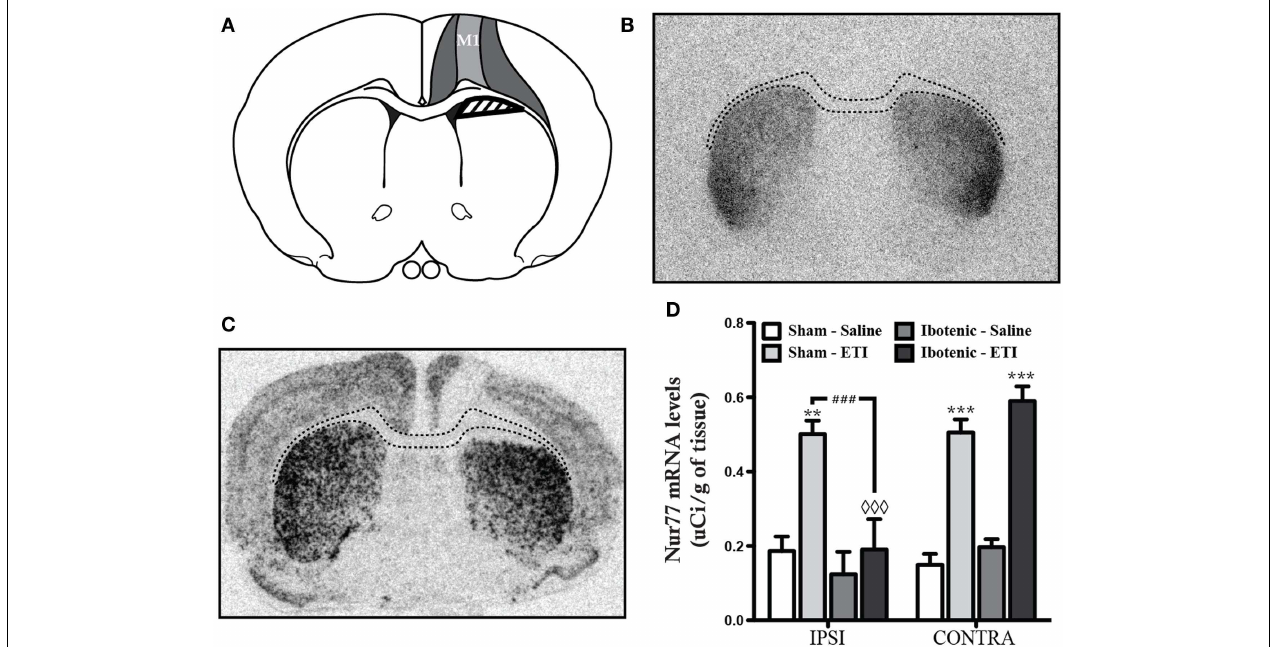
position of the corpus callosum identified on an adjacent section after Nissl staining (not shown). ( C ) Representative autoradiogram showing in situ hybridization of the Nur77 mRNA after eticlopride (ETI) administration. ( D ) Quantification of striatal Nur77 mRNA levels in the ipsilateral (IPSI) and contralateral (CONTRA) sides of the lesion in animals treated with saline or eticlopride (ETI) and bearing a sham or an ibotenic acid-induced lesion. Data are expressed in µ Ci/g of tissue. Histogram bars represent means ± SEM ( N = 5, ** p < 0.01 and *** p < 0.001 vs. same side control (Sham-Saline); ### p < 0.001 vs. IPSI side of Ibotenic-ETI group and ♦♦♦ p < 0.001 vs. CONTRA side of Ibotenic-ETI